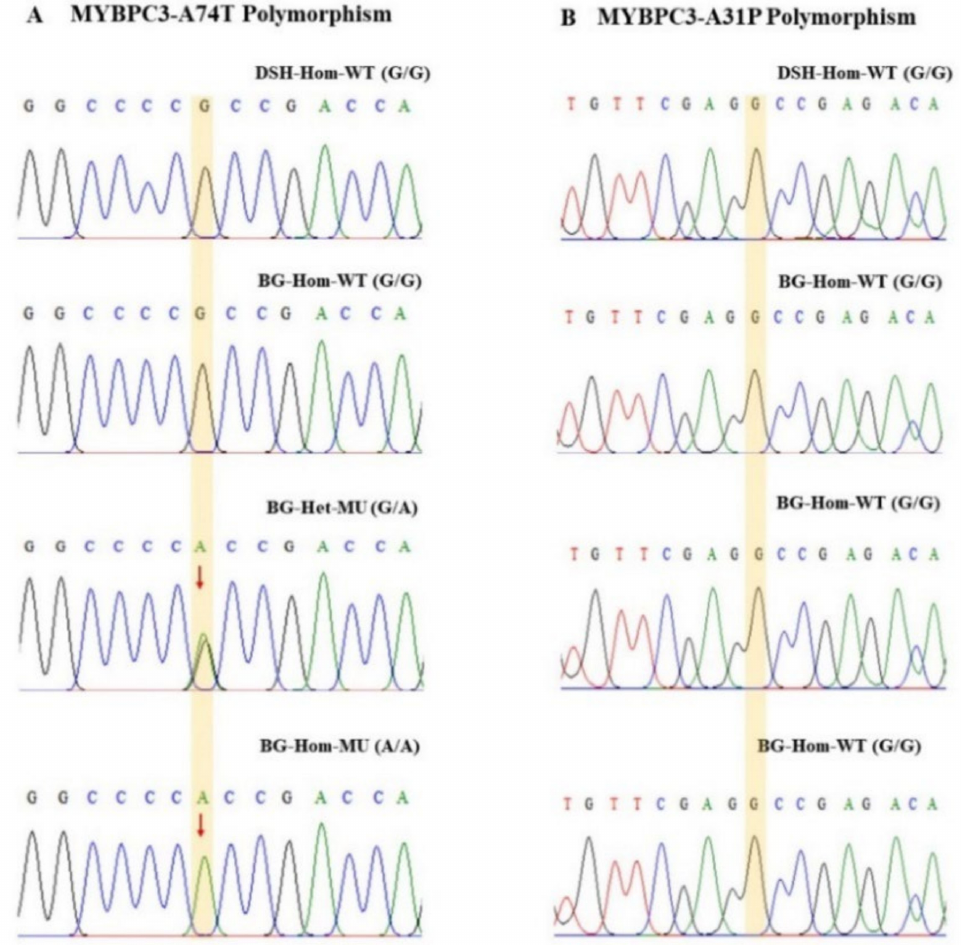
Figure 5. Sequence of MYBPC3 mutation in the study animals: ( A ) MYBPC3-A74T polymorphism; ( B ) MYBPC3-A31P polymorphism. DSH = Domestic short hair; BG = Bengal cat; WT = wild-type; HET = heterozygous mutation; HOM = homozygous